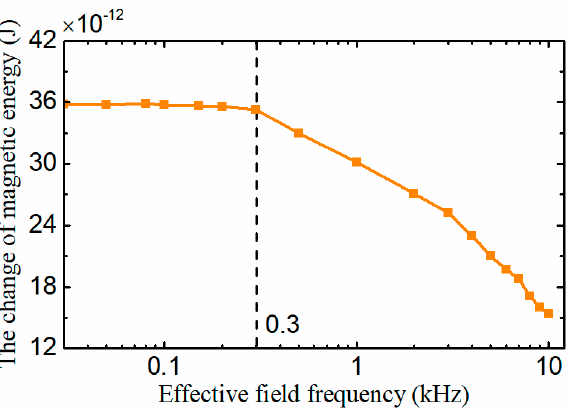
Figure 7. The change of magnetic energy stored in excitation coil under different effective field frequencies.